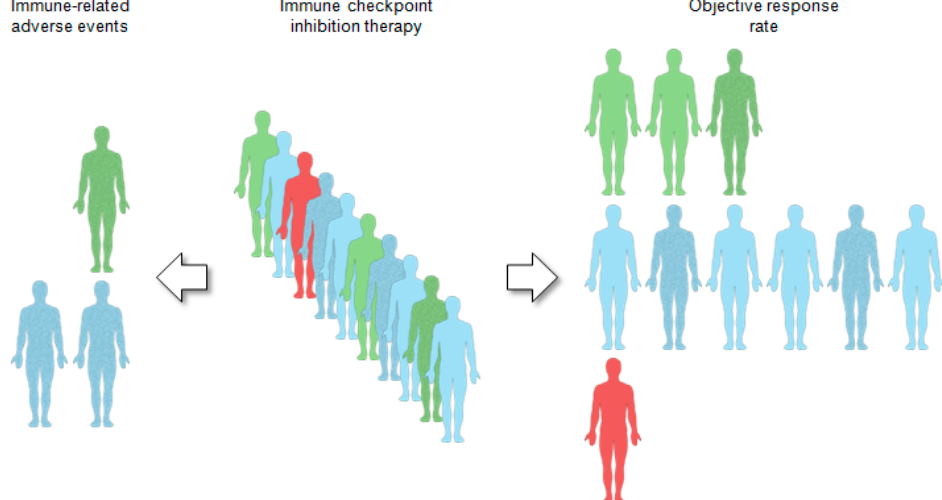
Figure 1. Companion diagnostics for immunotherapy by immune checkpoint inhibition. A limitation of immunotherapy by immune checkpoint inhibition (ICI) is the low response rate and only a small subset of head and neck cancer patients achieves a durable clinical benefit. Main challenge for molecular biomarkers is their predictive value not only to discriminate between responder (green patients) and non-responder (blue patients), but ideally also to assess the risk for a hyper-progressive disease (red patient) under ICI therapy. Establishment of biomarkers that enable early identification of patients at higher risk for severe immune-related adverse events (mottled patients) is another emerging research field of unmet medical